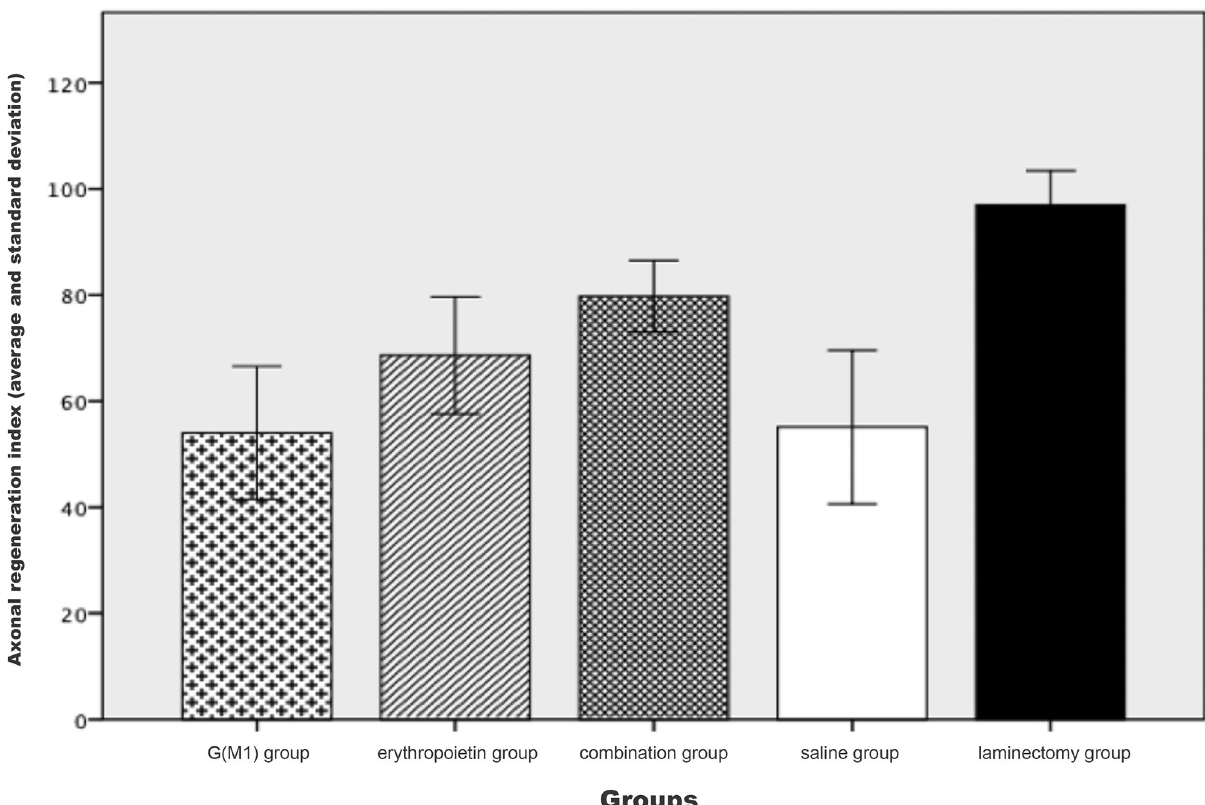
Figure 4 - Axonal regeneration index for each